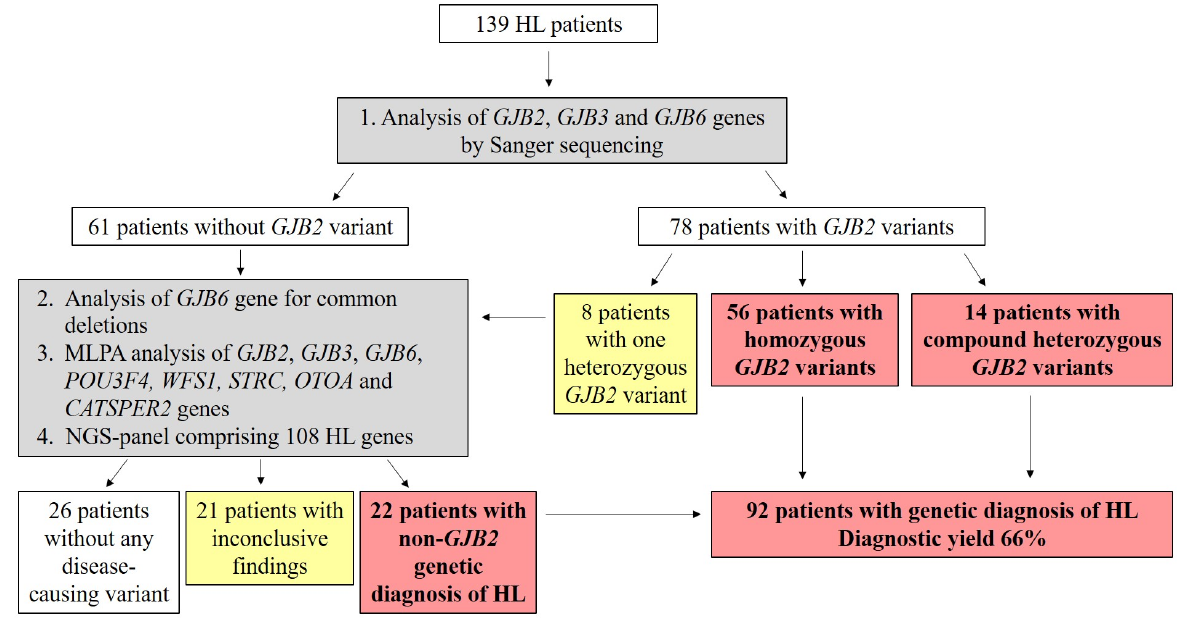
Figure 1. Workflow and major screening findings of the stepwise genetic analysis used with the Hungarian NSHL patient cohort. NSHL: nonsyndromic hearing loss; MLPA: multiplex ligation- dependent probe amplification; NGS: next-generation sequencing. Inconclusive findings include cases with only one heterozygous variant in autosomal recessive genes and cases with variants with both autosomal dominant and recessive inheritance; where, the genotype–phenotype comparison could not make a clear diagnosis.